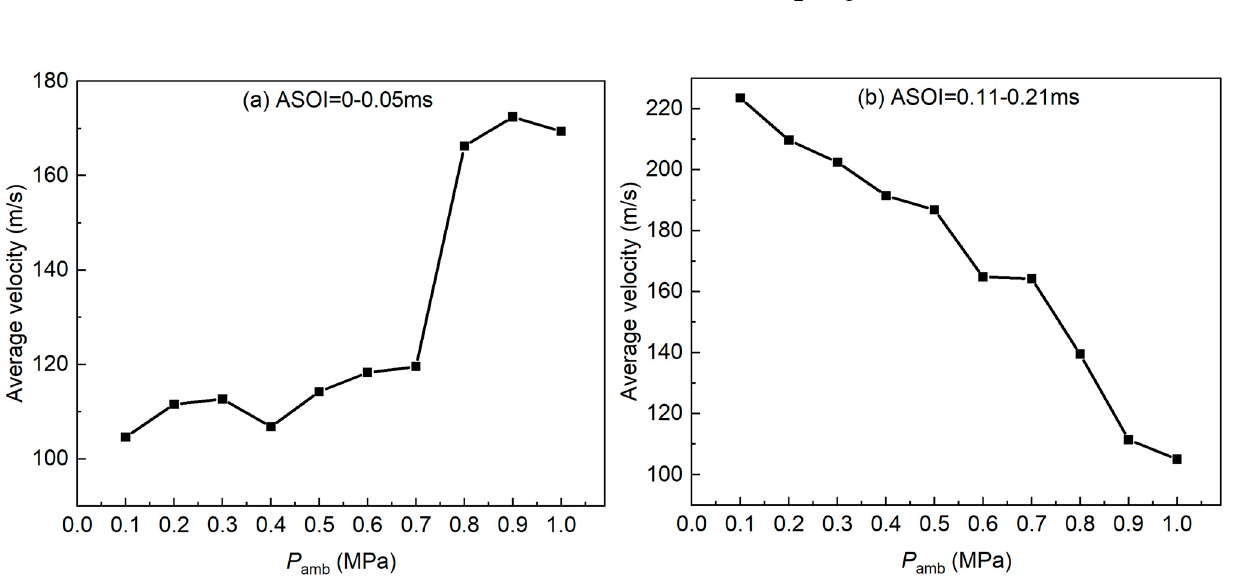
Figure 13. Average spray tip velocity, ( a ) acceleration stage, ( b ) stable stage, P inj = 100